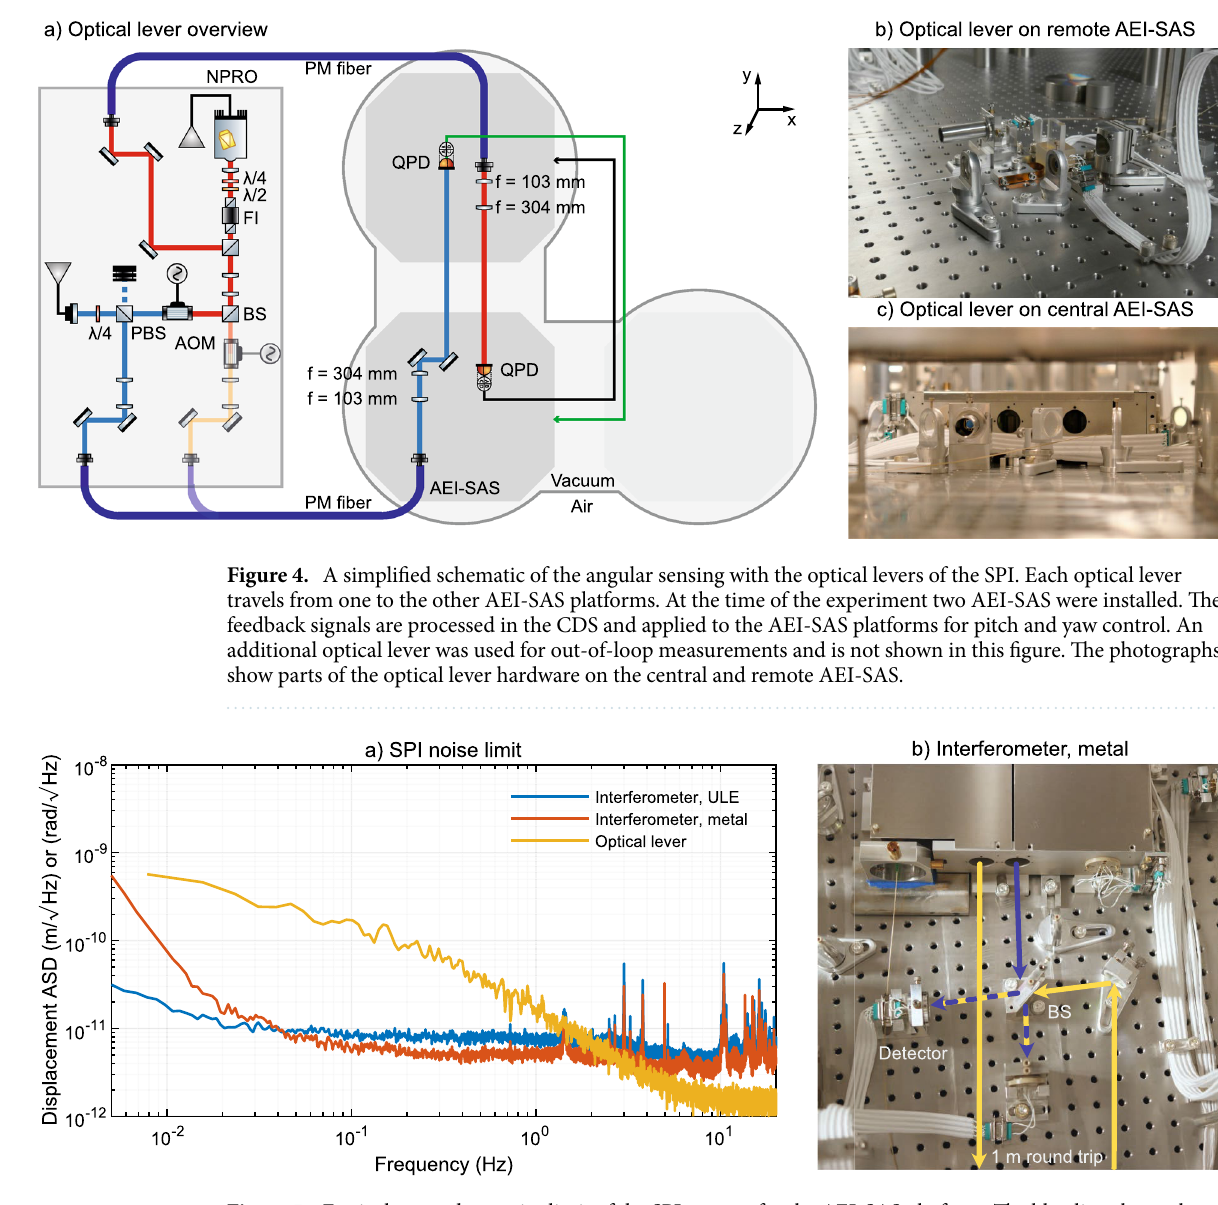
Figure 5. Equivalent readout noise limit of the SPI sensors for the AEI-SAS platform. The blue line shows the readout noise of the reference interferometer. The red line shows an additional interferometer, partially built using standard optical mounts, with an intentional arm length mismatch of about one meter. The stability is even better above 50 mHz due to better fringe visibility of the interferometer. At lower frequencies, thermal drift of the mounts is probably the dominant source of noise. These measurement results show that the stability of the ULE base plate is relevant at frequencies below 50 mHz . The more interesting range for gravitational wave detectors is between 100 mHz and 1 Hz , and here metal mounts are sufficient. The yellow line shows the readout noise limit for the optical lever in pitch and yaw. All measurements were calibrated to show the equivalent sensitivity for the AEI-SAS platform control. The metal test interferometer can be seen in the